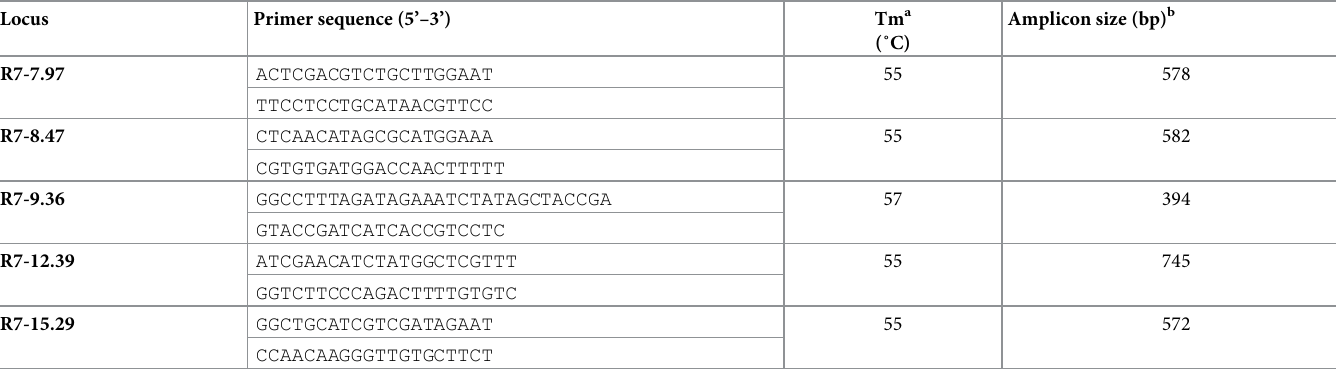
Table 1. PCR markers for radish root skin